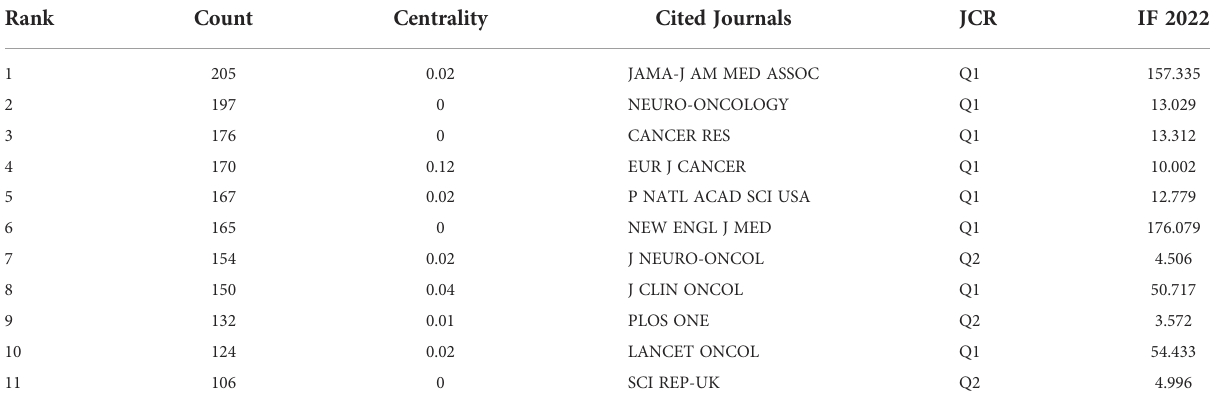
TABLE 3 Top 10 co-cited journals of related publications.